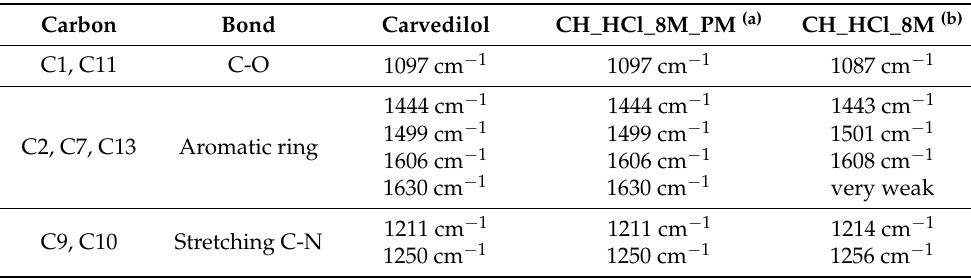
Table 2. Comparison of the IR bands for active principle, physical mixture, and active principle– halloysite hybrids.